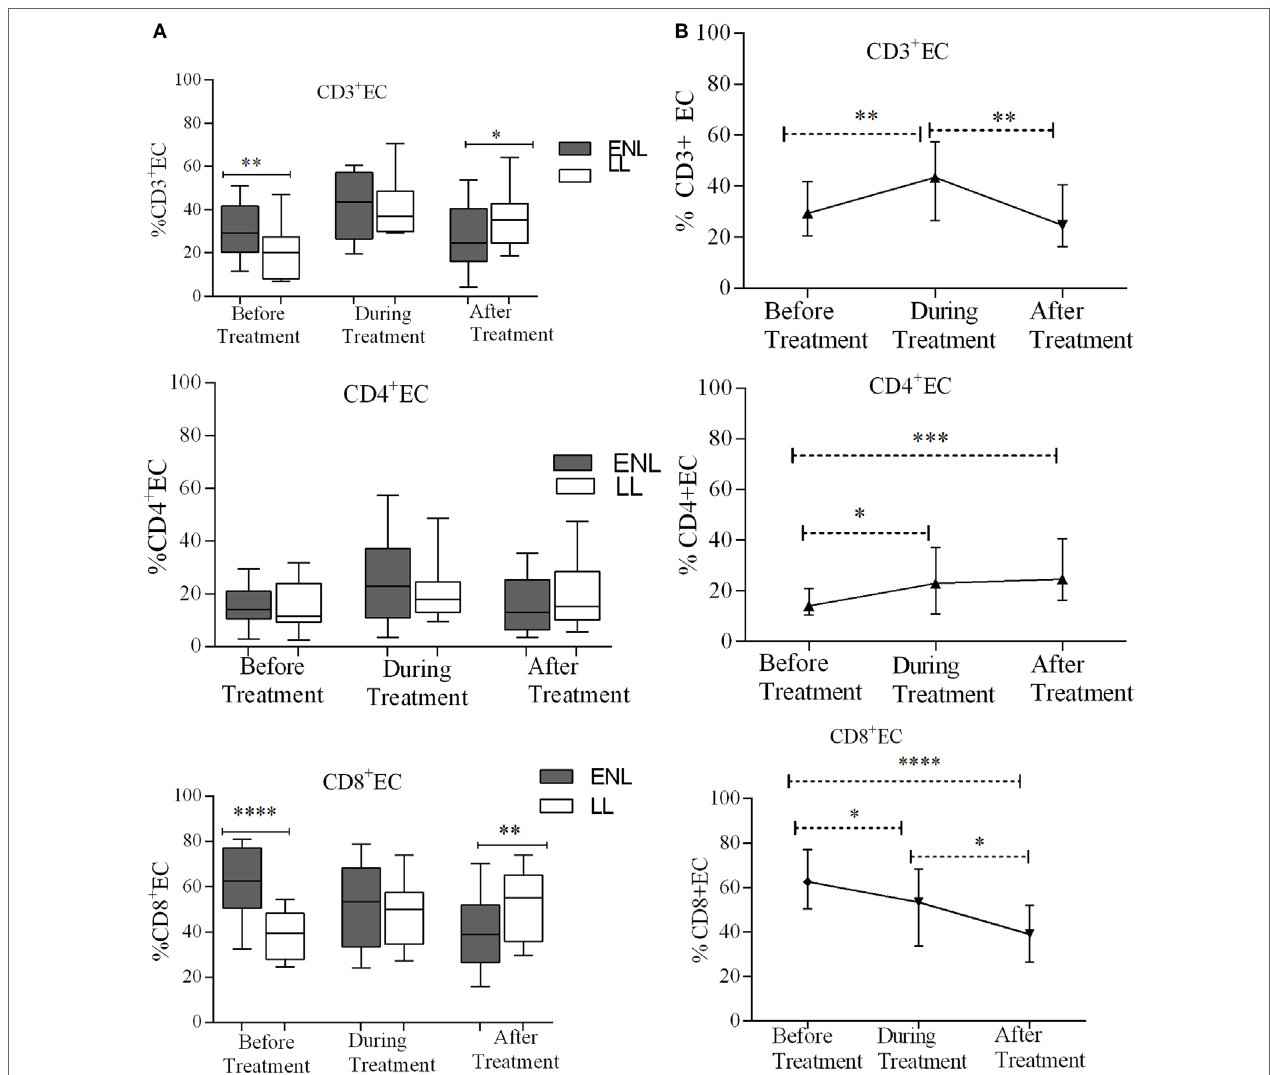
FigUre 6 | Median percentage of CD3 + , CD4 + , and CD8 + effector T-cells: (a) in patients with erythema nodosum leprosum (ENL) and lepromatous leprosy (LL) controls before, during, and after treatment, (B) within ENL patients before, during, and after treatment. * P ≤ 0.05; ** P < 0.005; *** P < 0.001; **** P < 0.0001 . Box and whiskers (a) and error bars (B) show median ± interquartile